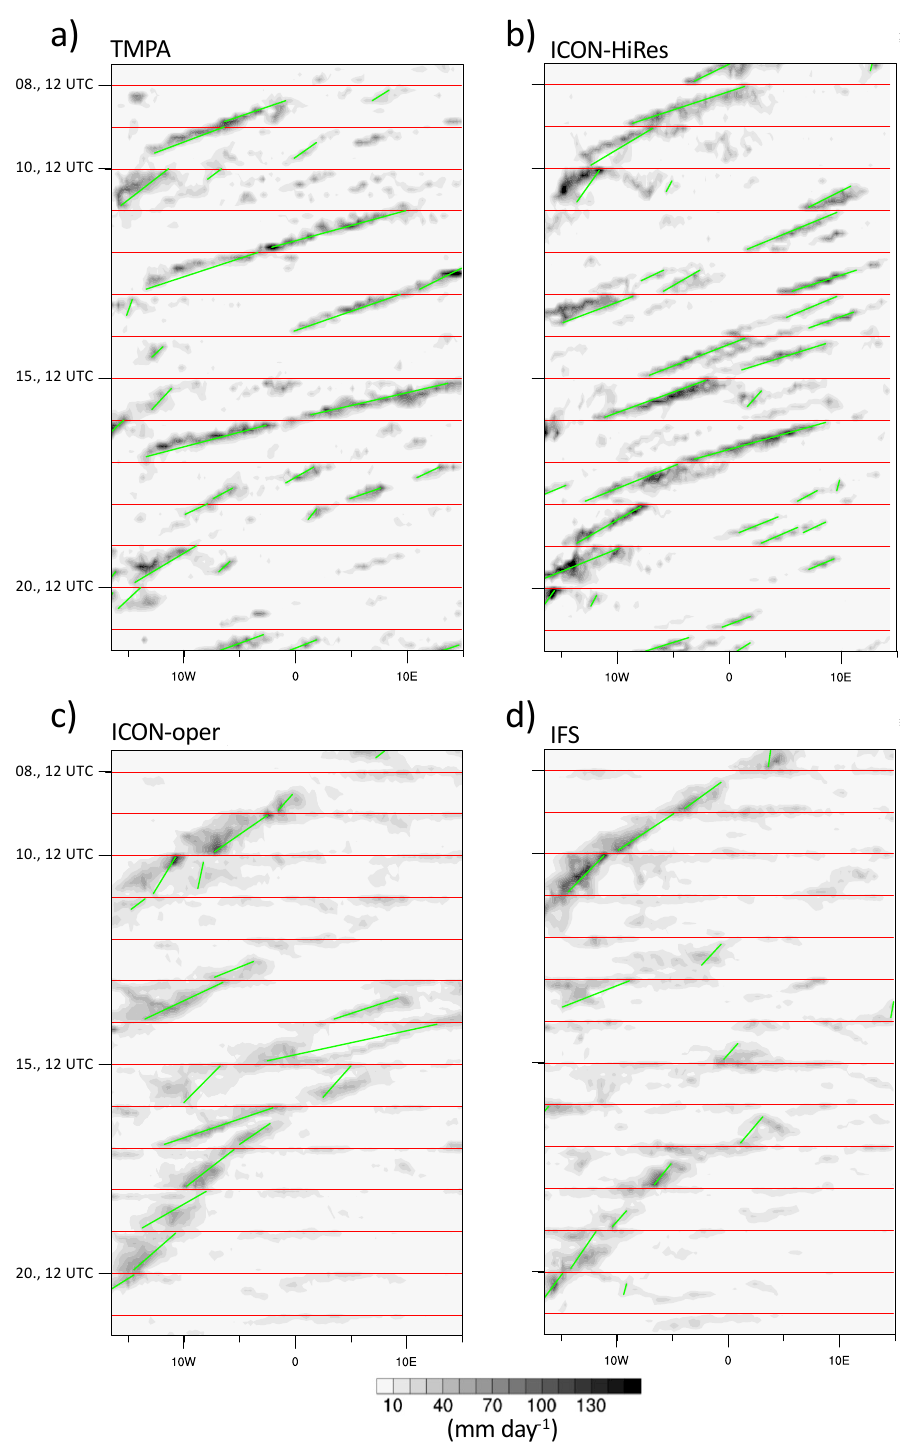
Figure 1. Hovmöller diagrams of three-hourly mean precipitation for the period 8 August 2016 00 UTC–22 August 2016 00 UTC over West Africa (10 ◦ N–15 ◦ N, 16.5 ◦ W–15 ◦ E, land only): ( a ) TRMM Multi-satellite Precipitation Analysis (TMPA); ( b ) the Icosahedral Non-hydrostatic model (ICON)-HiRes; ( c ) ICON-operational (oper); and ( d ) Integrated Forecast System (IFS). All model data were coarse-grained to 0.25 ◦ × 0.25 ◦ , i.e., the resolution of the observations. Green lines indicate objectively-identified westward-propagating precipitation features (see the main text for details). Horizontal lines indicate 12 UTC of every